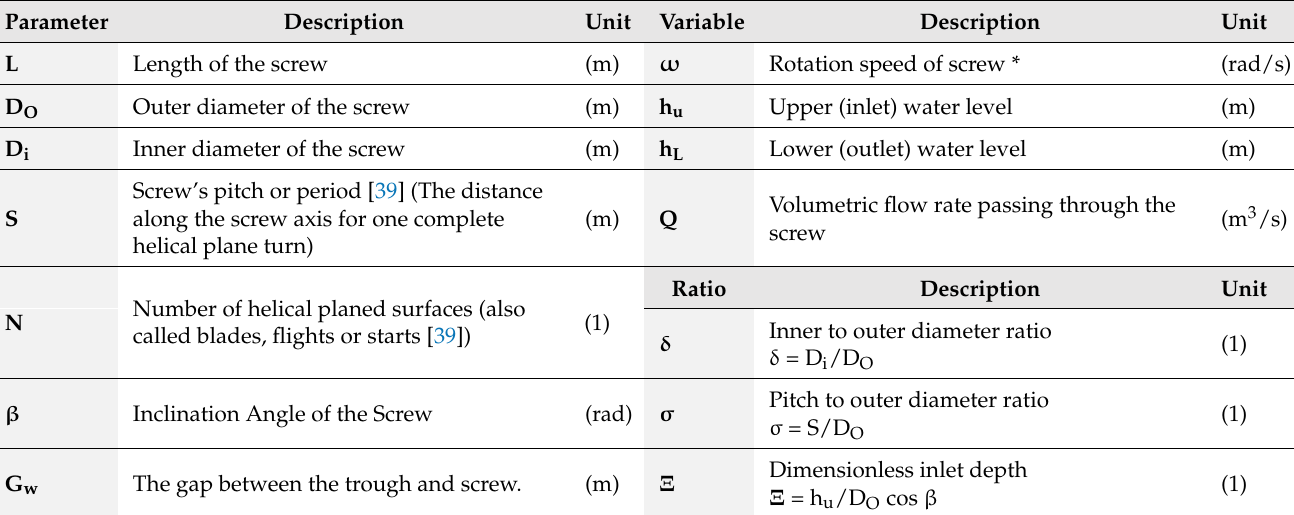
Figure 2. Required parameters to define Archimedes screw geometry [6,40]. Table 1. Archimedes screws’ geometry and operating